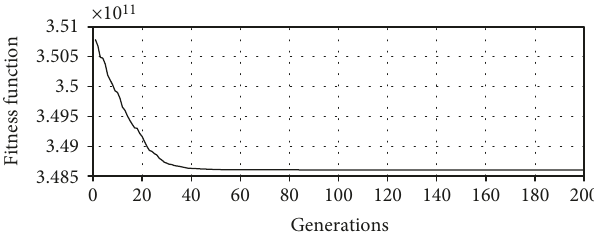
Figure 20: Evolution of the fi tness function of strategy 5 through generations.